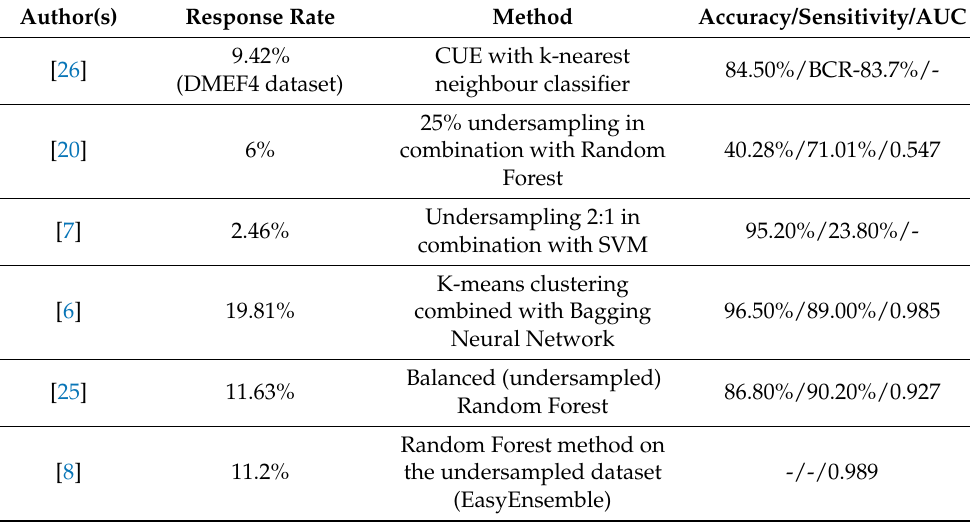
Table 1. Class balancing in previous customer response model